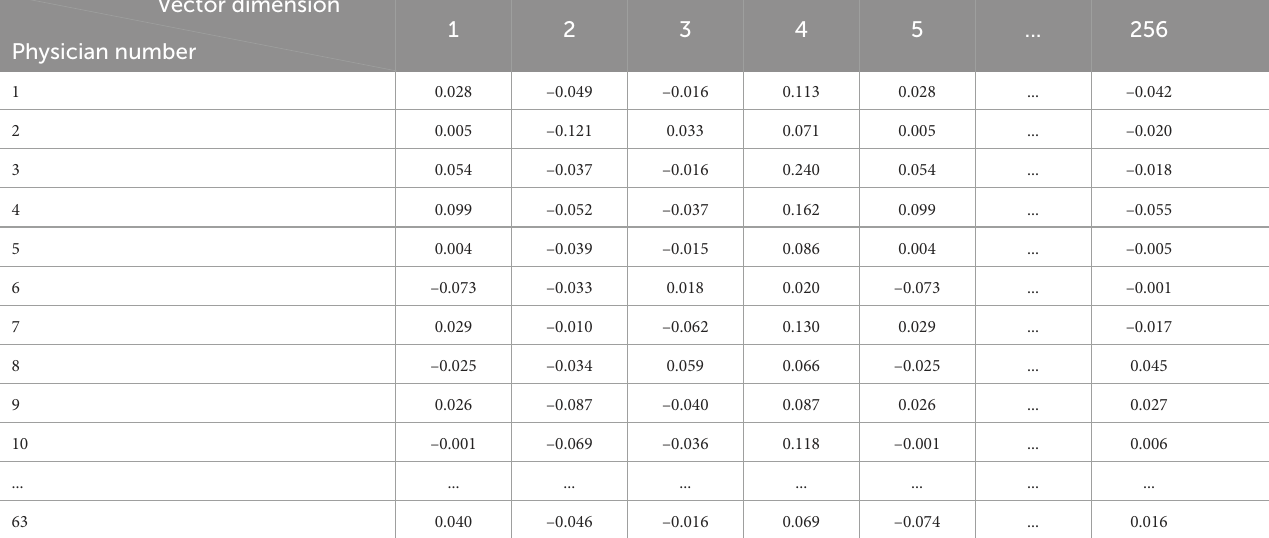
TABLE 10 The vector of the physician’s consulted text.